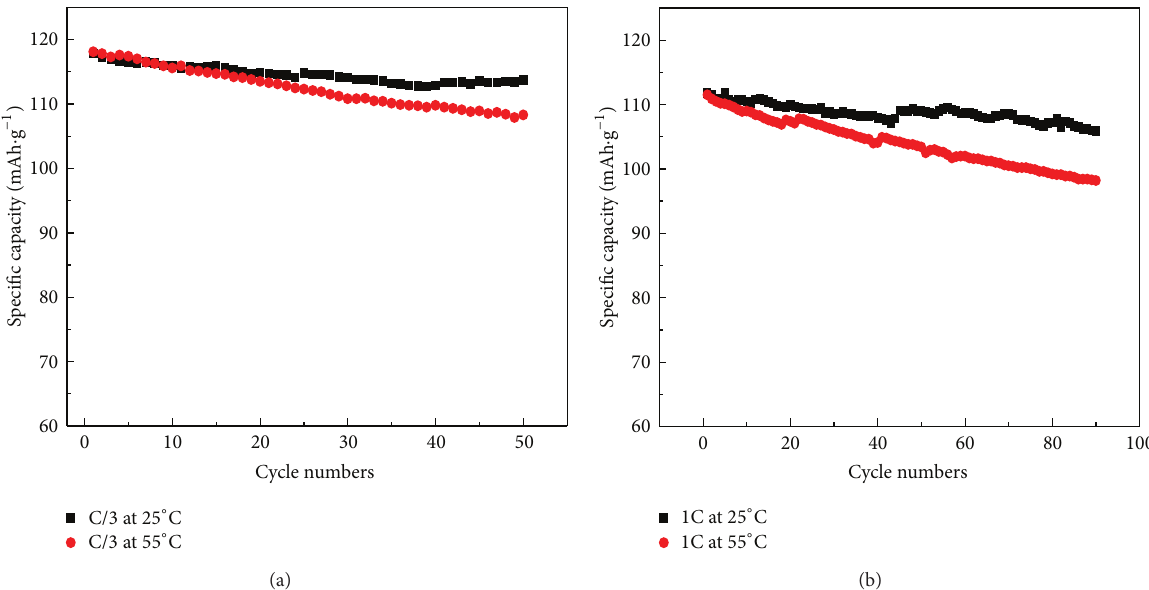
Figure 4: Cycling performance of the Li 1.02 Mn 1.92 Al 0.02 Fe 0.02 Cr 0.02 O 3.92 F 0.08 electrode at different current densities in voltage range of